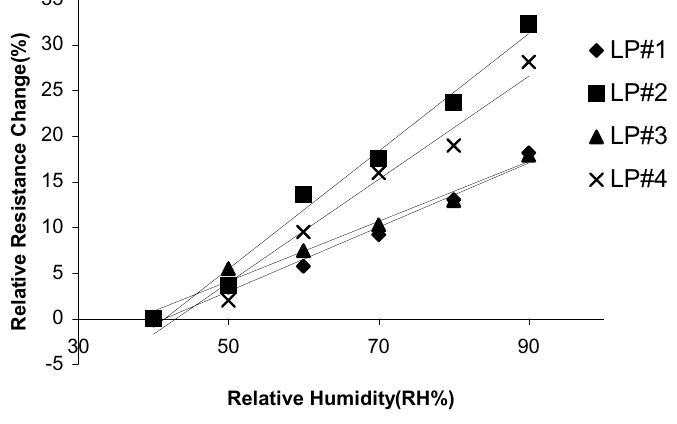
O /SiO at 30 o C. 2 3